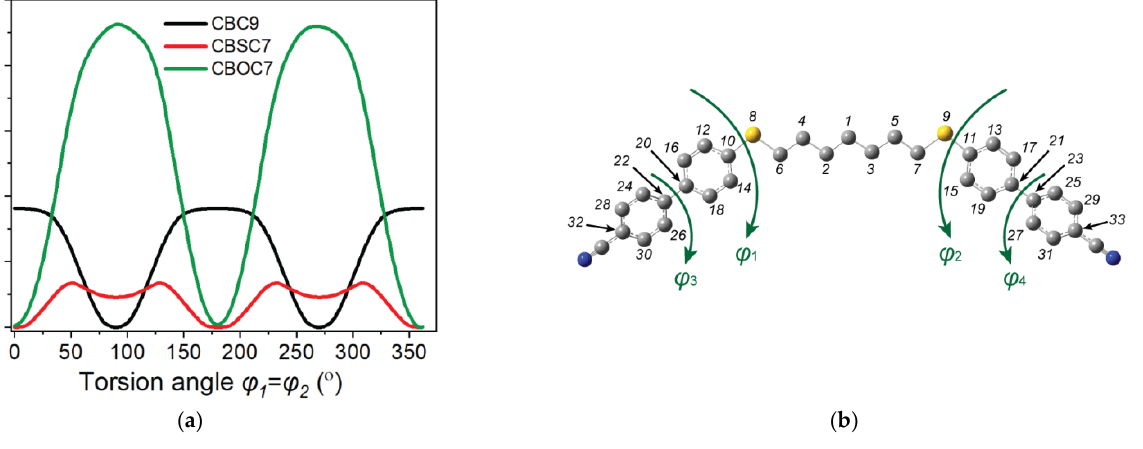
Figure 1. ( a ) The calculated potential energy functions for the torsional motion of the cyanobiphenyl dimers relative to the minimum value ( φ 1 or φ 2 ); black solid line — CBC9CB dimer, red solid line — CBS7SCB dimer, green solid line — CBO7OCB dimer. ( b ) Definition of the investigated dihedral angles of the dimers.